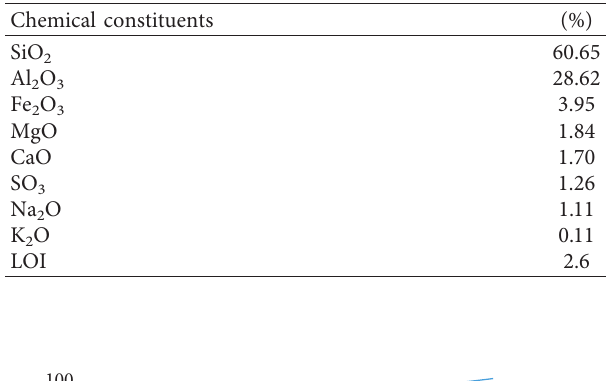
Table 1: Chemical compositions of fly ash.